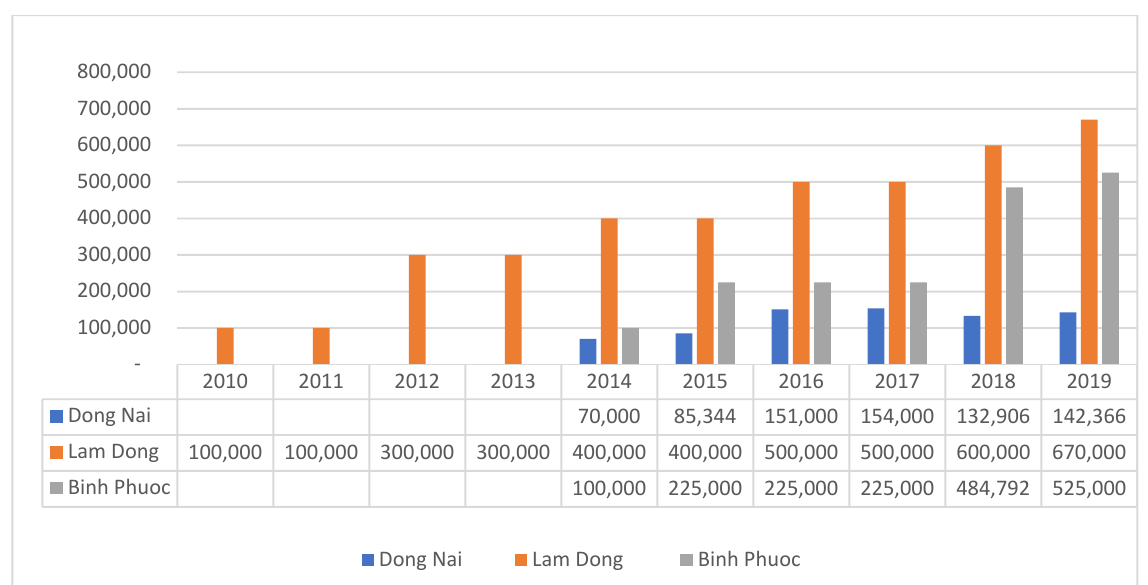
Figure 8. PFES unit prices. Source: Cat Tien National Park. Because PFES unit prices in Dong Nai are considerably lower than in Binh Phuoc and Lam Dong (Figure 8), Cat Tien National Park decided to use forest protection contract money under Decision 24 to add to the PFES payments made to people in Dong Nai. The national park balanced the budget, adding a unit price of VND 200,000–220,000 per hec- tare for the PFES forest protection area contracted to people in Dong Nai (Figure 9). How- ever, after a state audit disagreed with forest areas having two payment sources, Cat Tien National Park issued a new regulation whereby the amount contracted in Dong Nai may not exceed VND 300,000 per hectare. The increase in unit price for Dong Nai has helped bring it closer to the price paid in Binh Phuoc.